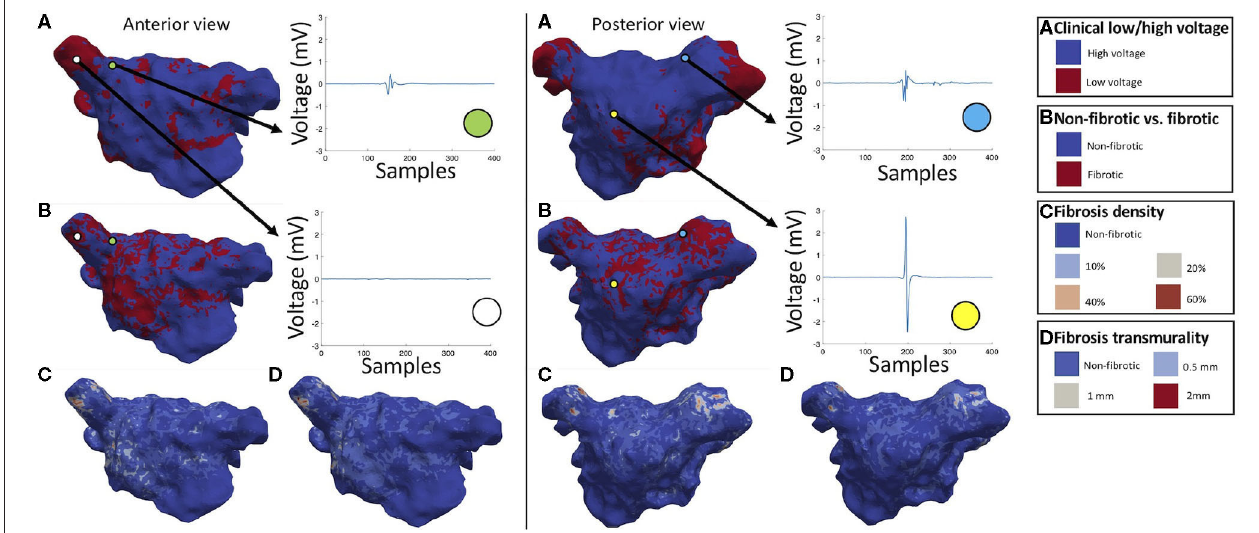
FIGURE 7 | Anterior and posterior view of patient maps for clinical low/high voltage (A) and classification results for non-fibrotic vs. fibrotic (B) , fibrosis density (C) , and fibrosis transmurality (D) . The green dot represents a signal at the base of the pulmonary vein which was marked as high voltage and classified as subendocardial (0.5mm) low density (10%) fibrotic tissue. The white dot refers to a signal recorded in the pulmonary vein classified as low voltage and high density (60%), transmural (2mm) fibrotic tissue. The yellow dot represents a high voltage area identified as non-fibrotic and the light blue dot indicates a signal collected in the pulmonary vein annotated as high voltage and classified as low density (20%), partially transmural (1mm) fibrotic tissue. Reused from Sánchez et al.